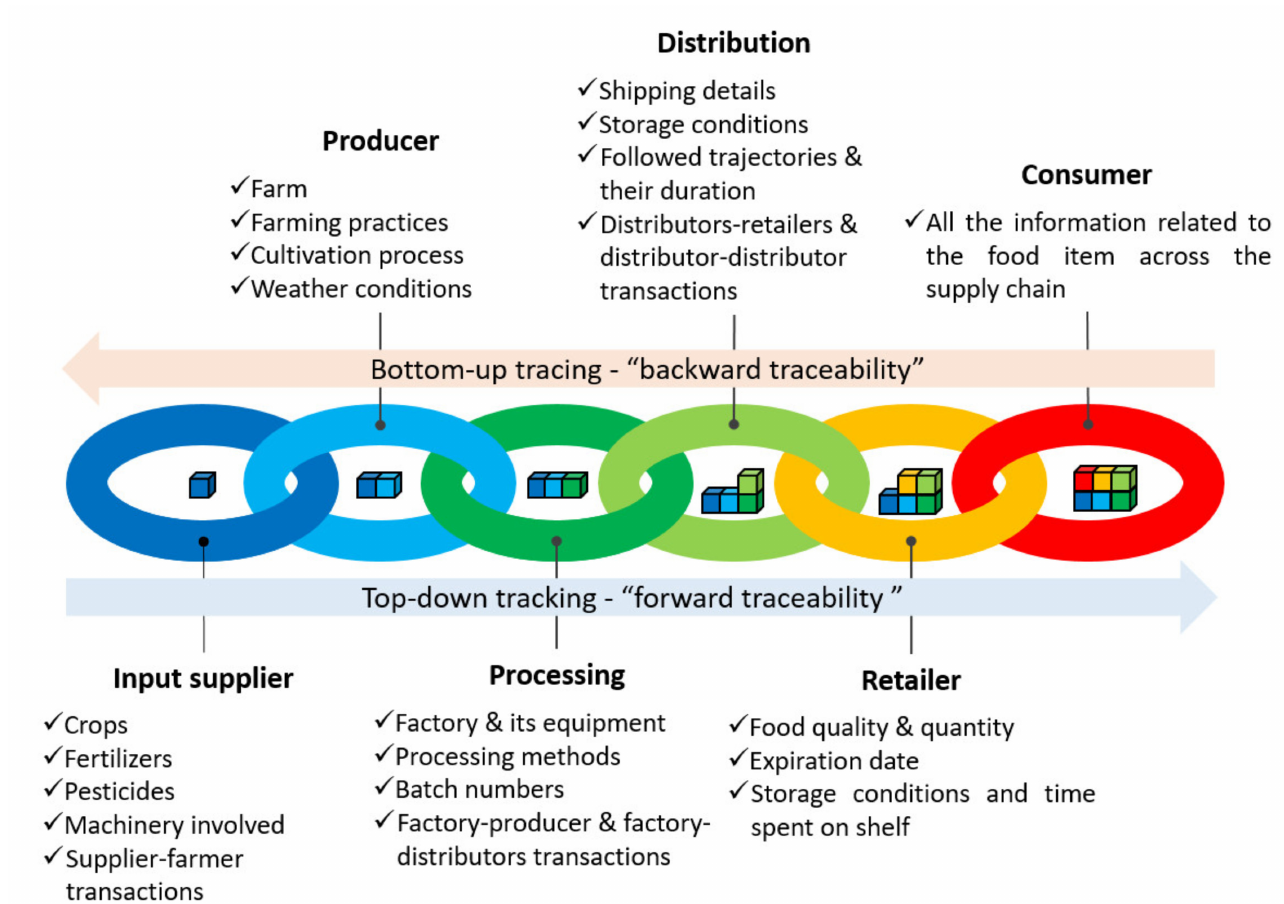
Figure 1. An illustrative example of a fresh produce supply chain along with the information recorded in each stage within a block; products flow forward the food supply chain, while both forward and backward traceability can take place following the product in either top-down or bottom-up direction across the food supply chain,